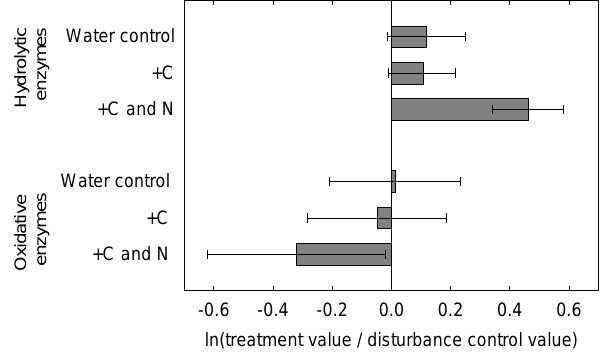
Figure 5. Meta-analytic summary of soil exo-enzyme activities in response to the delivery of root exudate mimics across two field experiments. Experimental treatments included disturbance controls, water controls, C-only exudate mimics, and C + N exudate mimics. The response ratio of experimental treatments relative to disturbance controls is shown. Error bars reflect bias-corrected bootstrapped 95% confidence intervals. Exo-enzymes were grouped into categories of hydrolytic enzymes that catalyze the decomposition of low molecular weight substrates (i.e. proteolytic, AP, NAG, and BG enzymes) and oxidative enzymes that catalyze the decomposition of high molecular weight substrates (e.g. the lignolytic enzymes PhenOx and PerOx).